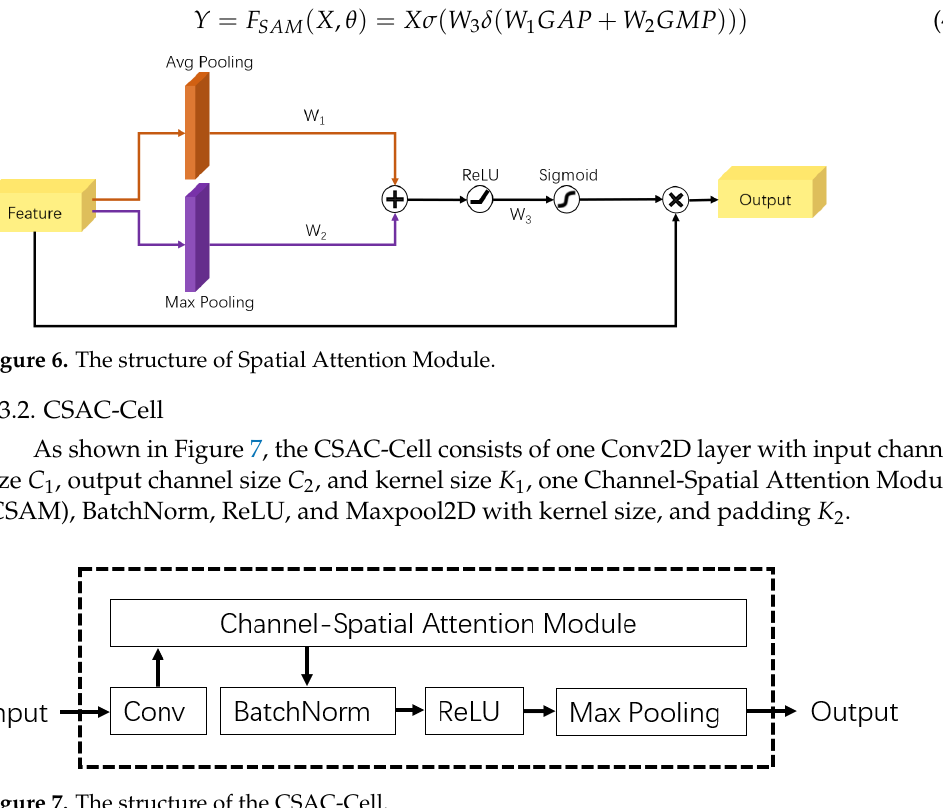
Figure 7. The structure of the